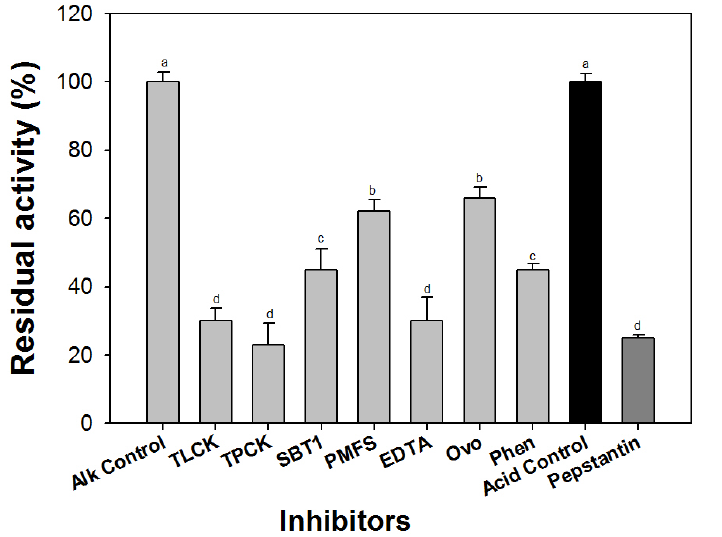
FIGURE 3 | Residual activity (%) of digestive proteases using several inhibitors on multienzyme extracts of short-tailed pipefish ( Microphis brachyurus ) juveniles. Alkaline proteases with no inhibitor (Alk control), tosylphenylanylchloromethyl ketone (TPCK), phenanthroline (PHEN), ethyl-diamine tetra-acetic acid (EDTA), tosyllysyl- chloromethyl ketone (TLCK), ovalbumin (OVO), soybean trypsin inhibitor (SBT1), phenyl methyl sulphonyl fluoride (PMSF), acidic proteases with no inhibitor (Acid control), pepstatin A (mean ± SD, n = 3). Columns with different letters represent significant differences (p < 0.05).